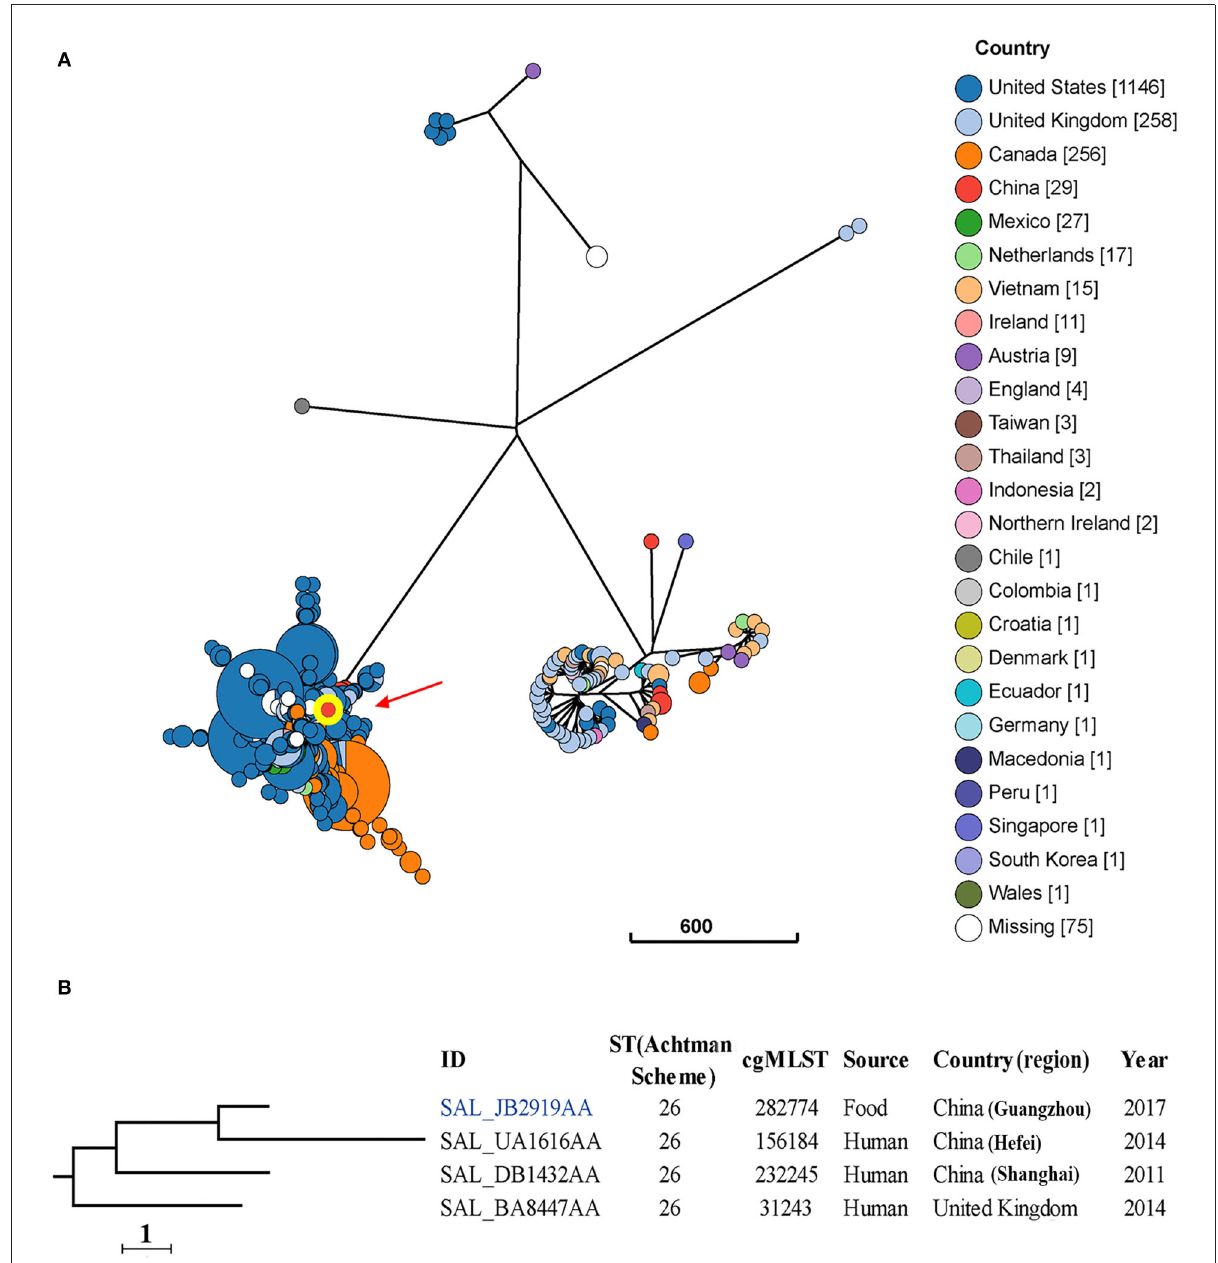
FIGURE3 Phylogenetic analysis of 1868 S. Thompson isolates from different sources and countries. (A) A minimum-spanning tree based on cgMLST analysis. The position of isolate 17Sal009 is indicated by red arrow and highlighted circle. Each circle represents a cgMLST group and the size of the circle is proportional to the number of isolates in that group. (B) Detailed information of strains in the branch contained 17Sal009. The isolate 17Sal009 is marked blue.